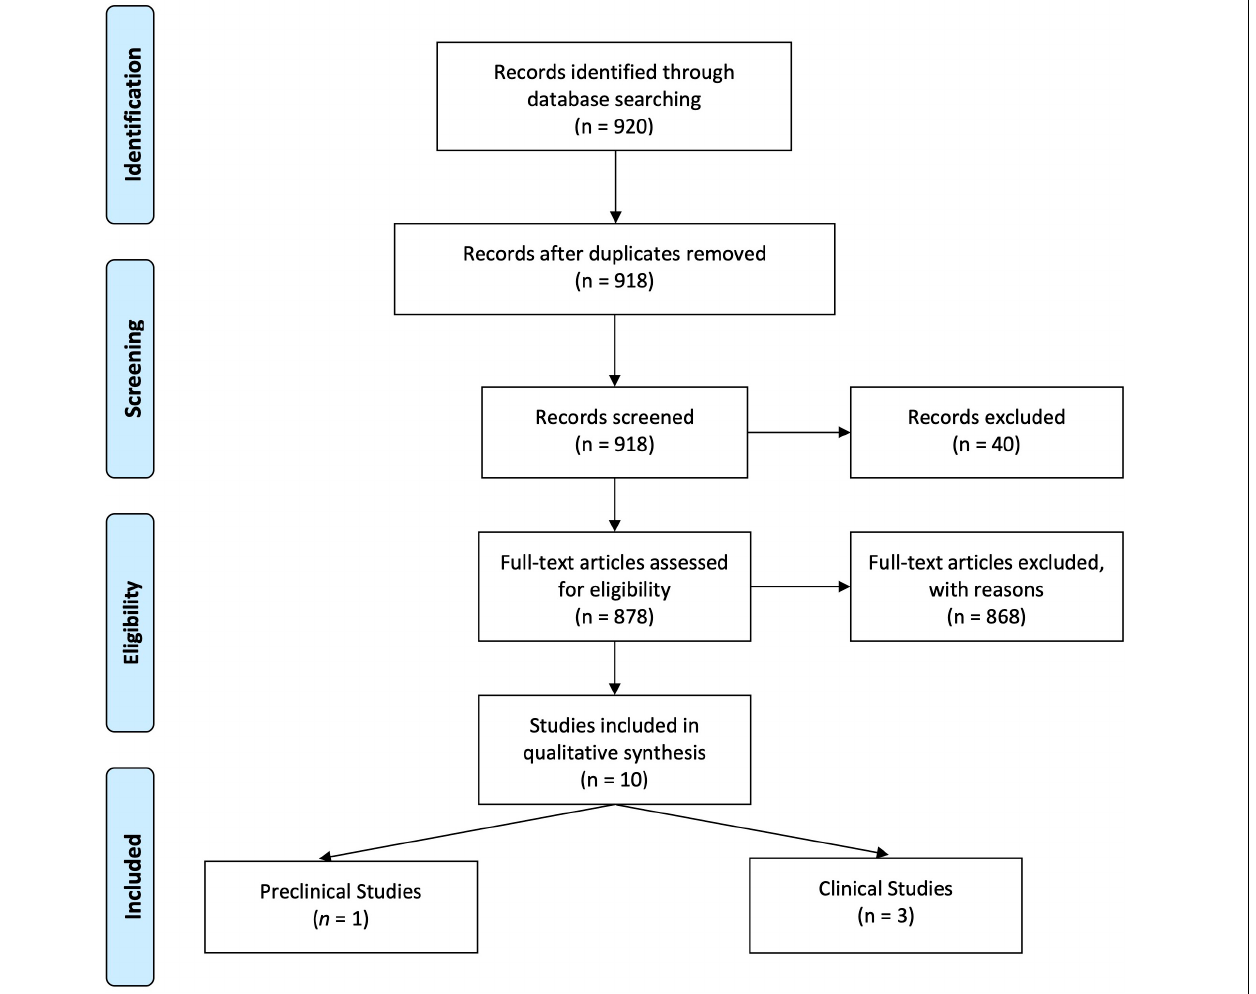
FIGURE 1 | PRISMA Flow